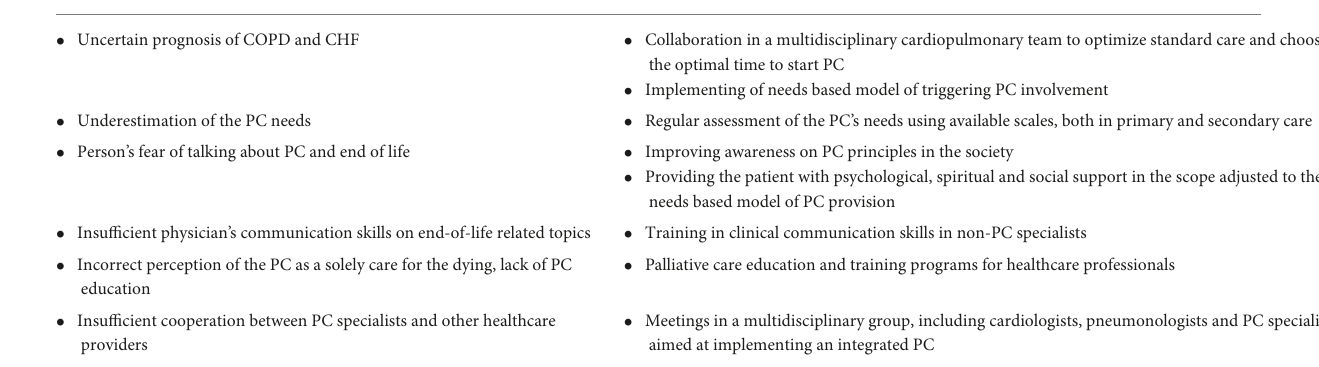
TABLE 2 The most common causes of insufficient PC involvement in people living with COPD and CHF; based on (3, 16, 20–23). Cause